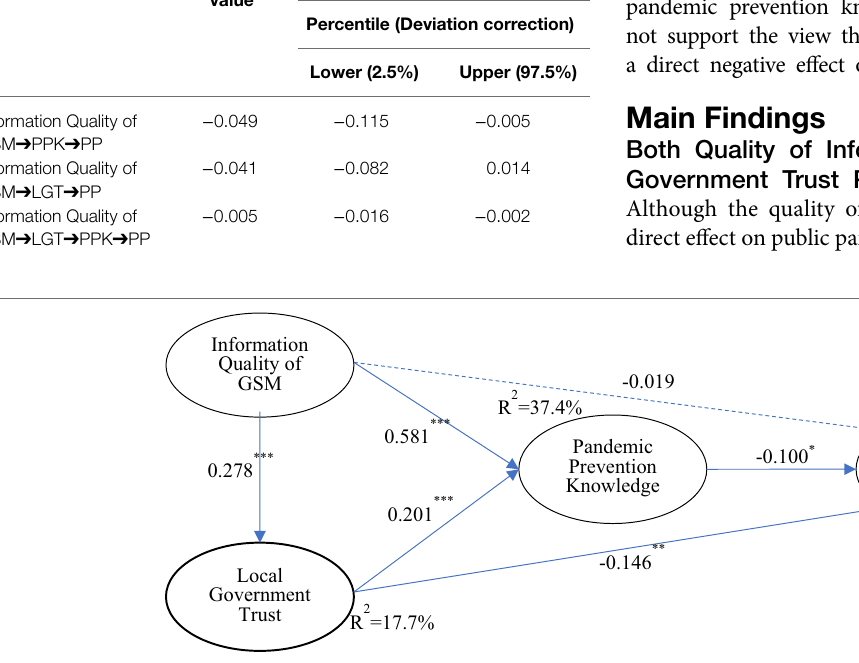
FIGURE 2 | The model results. * p < 0.10; ** p < 0.01; and *** p < 0.001. Local Government Trust is a second-order measurement model.